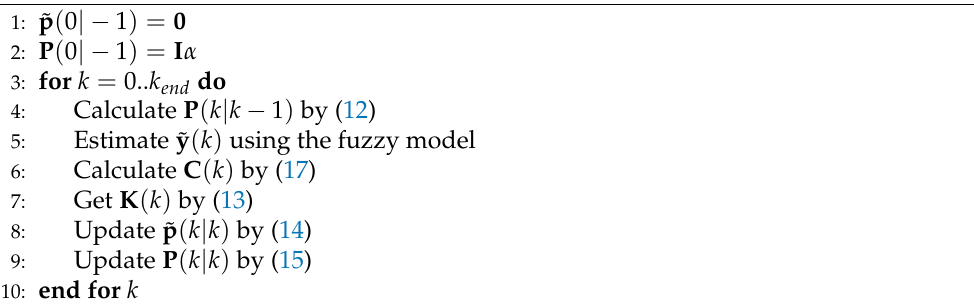
Algorithm 1 EKF algorithm for the adaptation of consequents.